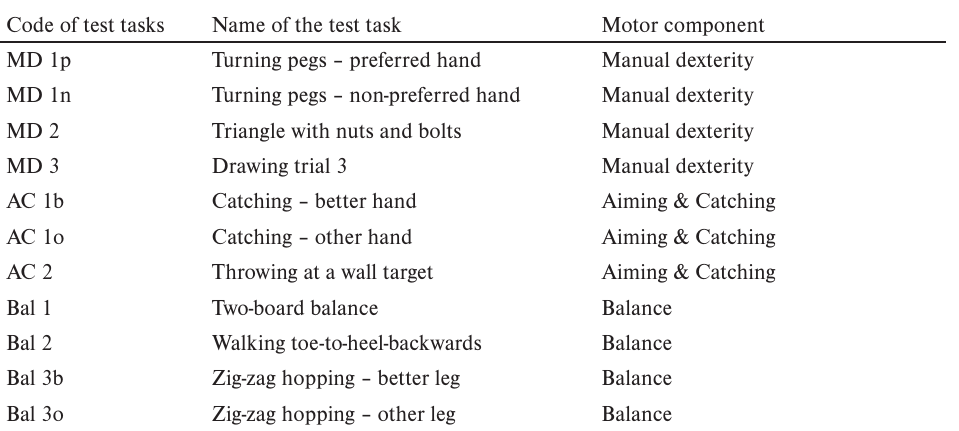
The test tasks of the MABC-2 test – age band 3 Code of test